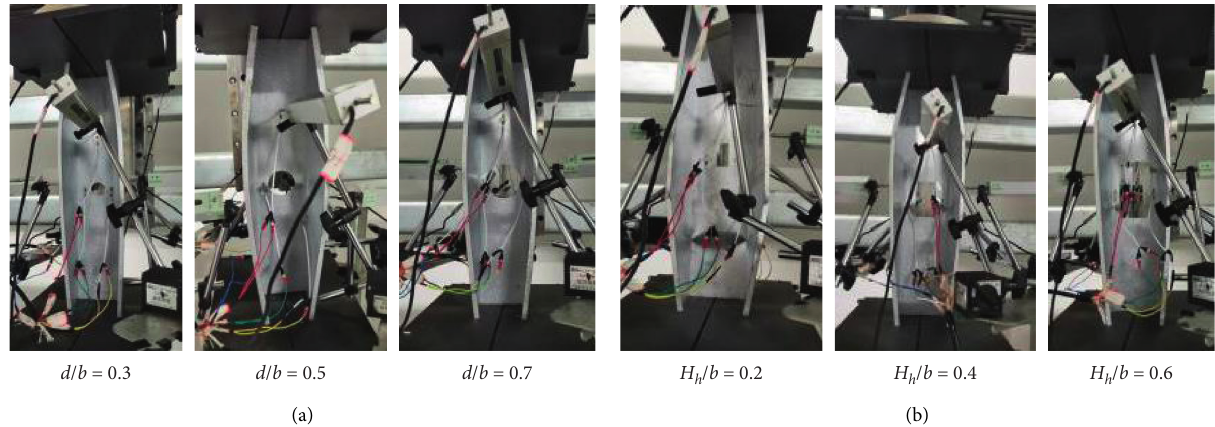
Figure 11: Comparison of the buckling mode for section 10010 series with different dimensions of holes. (a) Specimens with circular holes. (b) Specimens with rectangular